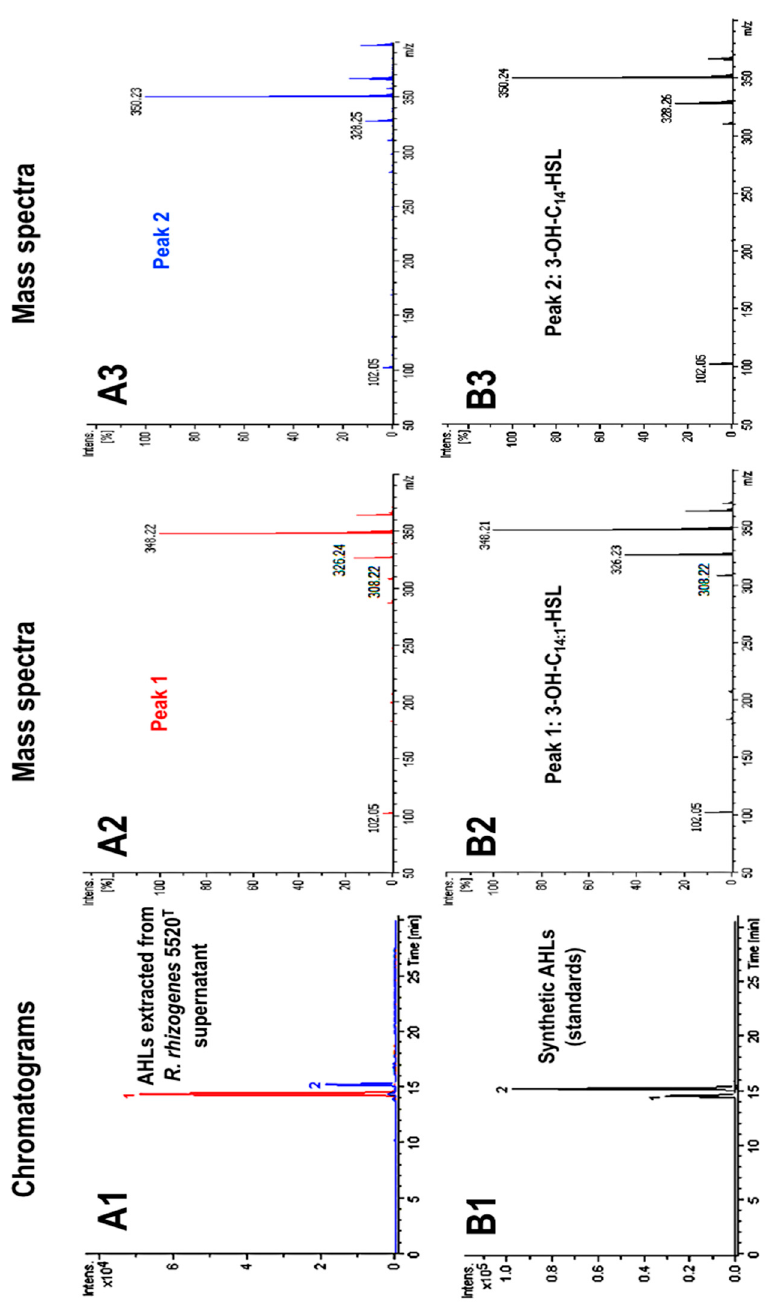
Figure 1. HPLC–MS analyses of AHL signaling molecules in R. rhizogenes culture supernatants. The chromatogram of an AHL extract from strain 5520 T ( A1 ) and associated mass spectra of compounds from chromatogram peaks 1 ( A2 ) and 2 ( A3 ) were compared to the chromatogram of a mixture of two synthetic AHLs, 3-OH-C 14:1 -HSL and 3-OH-C 14 -HSL ( B1 ), and the corresponding mass spectra of compounds from chromatogram peaks 3 ( B2 ) and 4 ( B3 ).